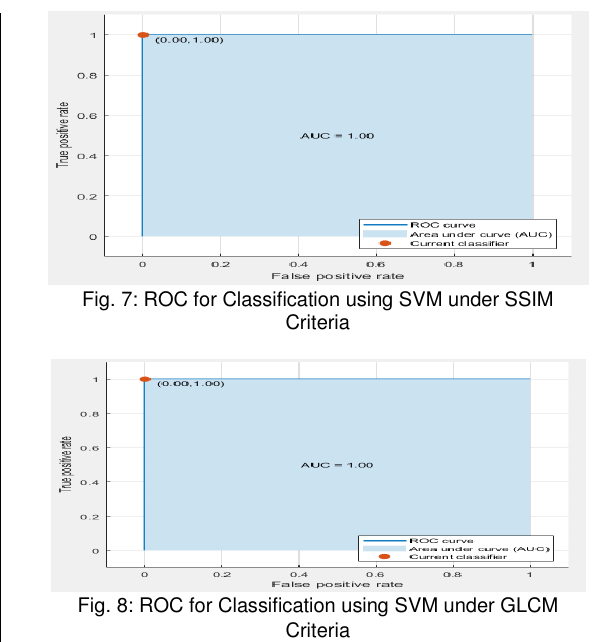
Fig. 7: ROC for Classification using SVM under SSIM Criteria